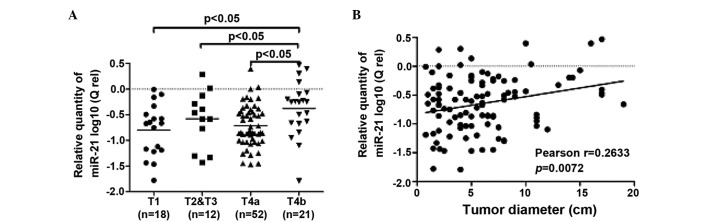
Serum microRNA-21 (miR-21) expression correlated with tumor size. (A) One-way ANOVA analyses showed that the serum miR-21 was significantly elevated in pT4b cases compared with pT1, pT2 and T3, and pT4a cases. There were no significant differences among pT1, pT2 and T3, and pT4a cases. (B) A Pearson correlation analysis showed that the serum miR-21 level and tumor size were positively correlated (r=0.2633, P=0.0072). The relative quantity (Qrel) of serum miR-21 was normalized to the serum miR-16 and miR-93 levels and expressed as the log10 of Qrel. The horizontal line indicates the mean.